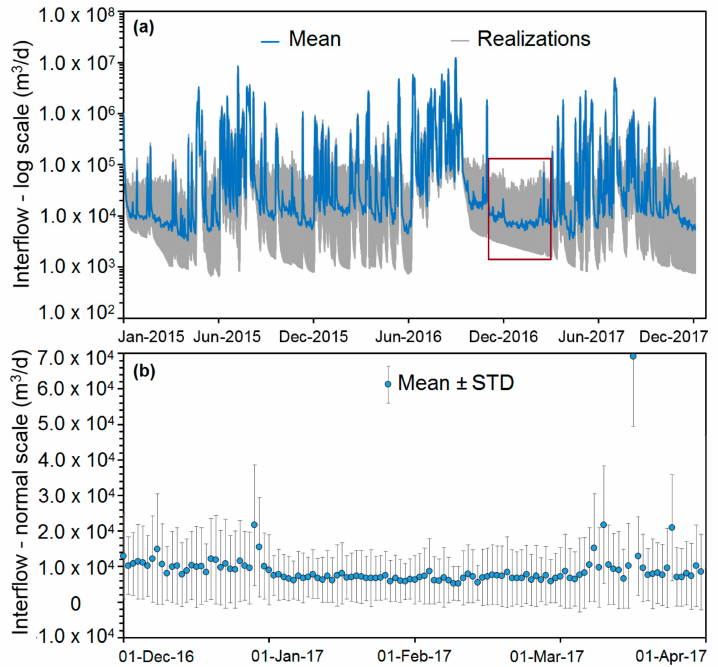
Figure 12. The interflow uncertainty induced by the precipitation variations in the Kaoping River: ( a ) the temporal variations of the interflow rates based on the 100 realizations, and ( b ) The selected dry season period to show the mean and STD of interflow